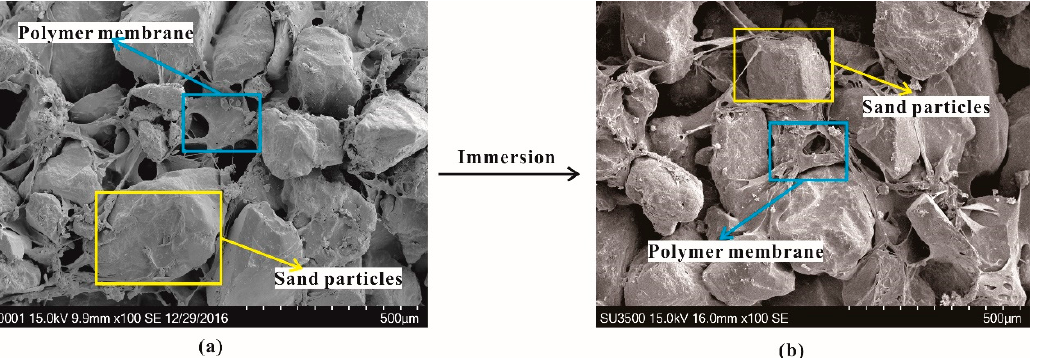
Figure 2. The SEM photomicrograph of the polymer-sand composite material for different periods: ( a ) Before immersion; ( b ) After immersion.